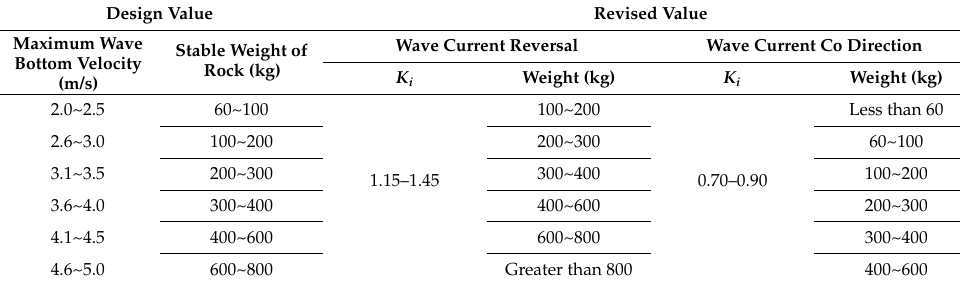
Table 4. Revision of stable weight of bottom protection